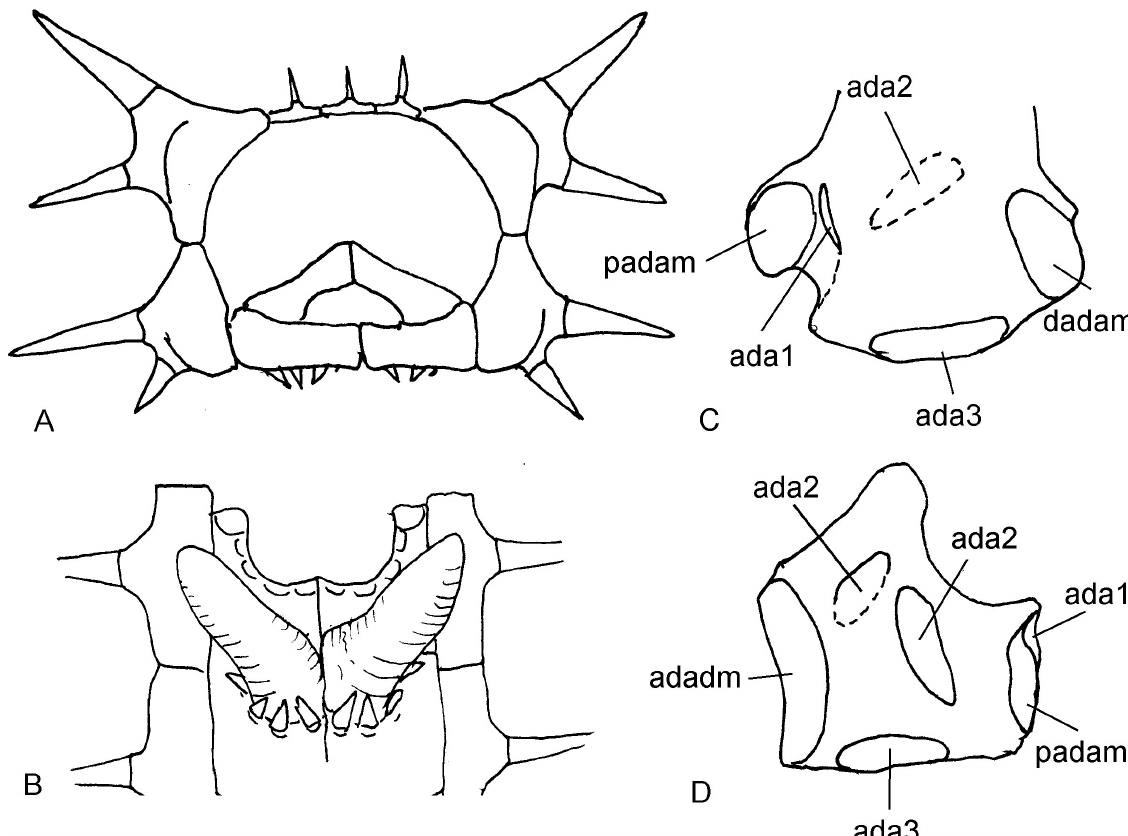
Fig. 11. Punkaster spinifera gen. et sp. nov., reconstructions and interpretation. A . Reconstruction of cross-section of arm. B . Reconstruction of ambulacral groove, with large podial basins and furrow spines. C . Ambulacral base, in actinal view. D . Abactinal face of adambulacral. Abbreviations: see Material and methods, and Fig. 3 for detailed morphological